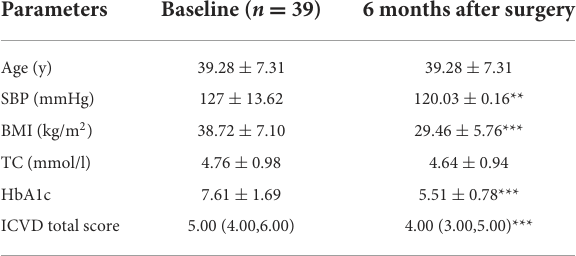
TABLE 5 Baseline and 6-month-post-operative characteristics in the diabetic subgroup.